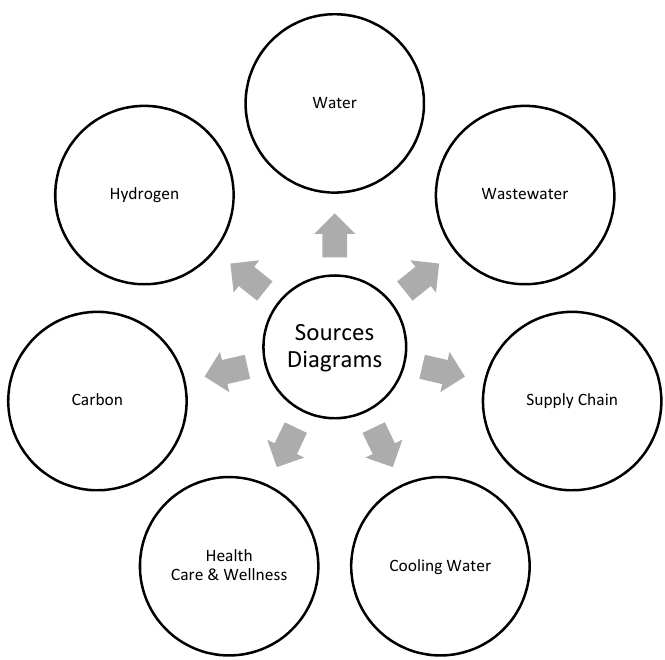
Figure 4. Possible applications of the Sources Diagram idea.